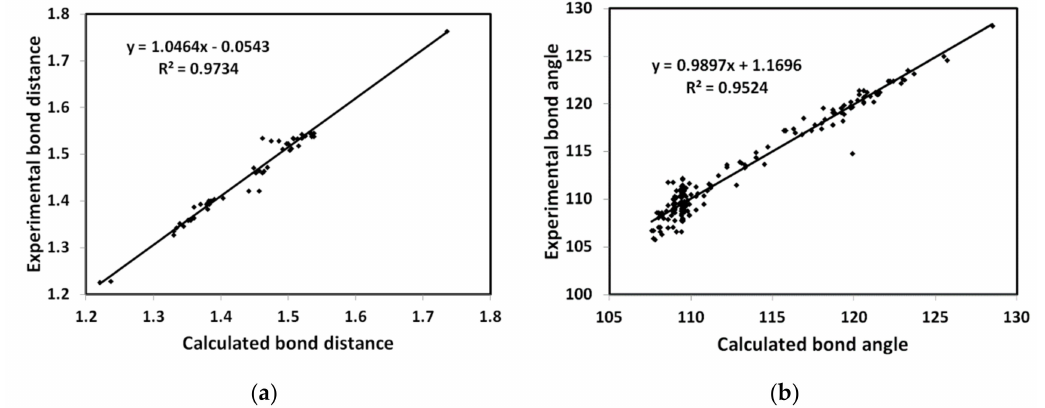
Figure 7. The calculated versus experimental ( a ) bond distances and ( b )